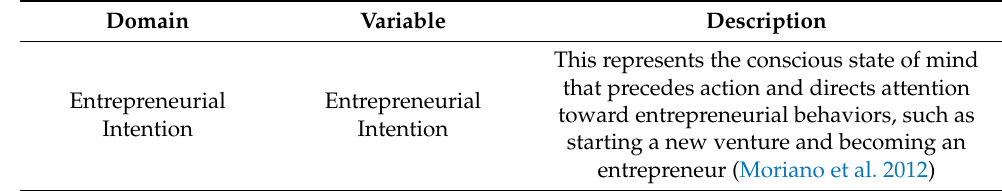
Table 1. Domain and description of the 10 entrepreneurial